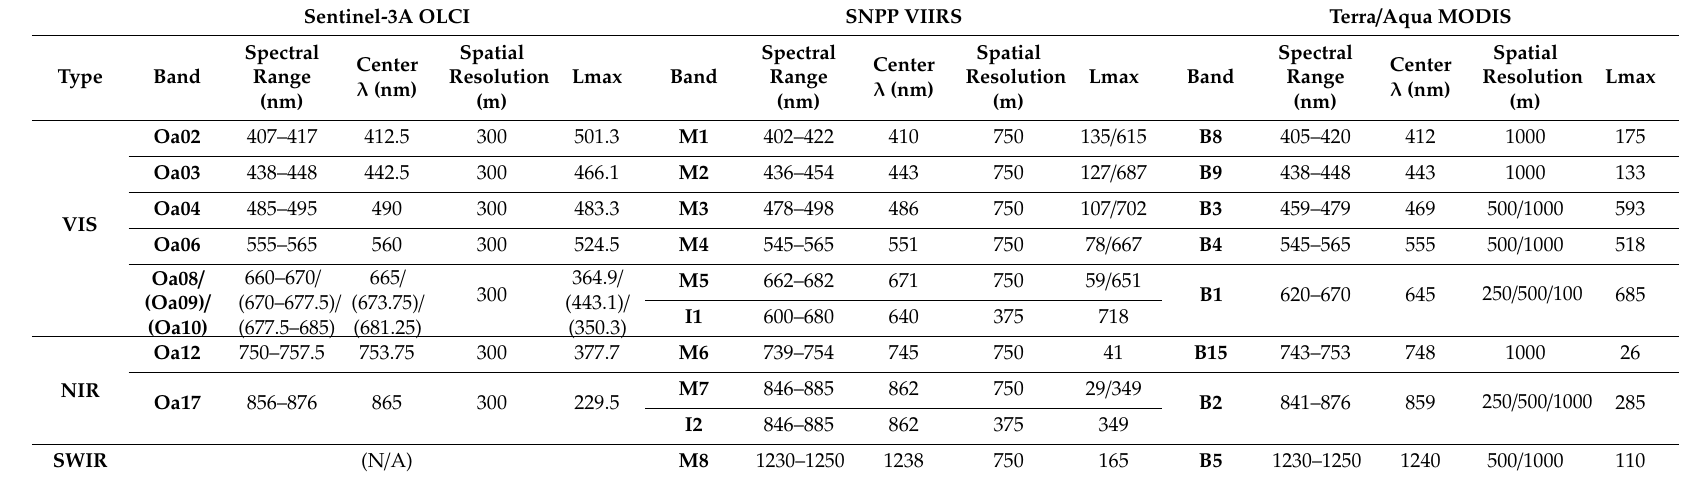
Table 2. The specifications of the matching RSBs of Sentinel-3A OLCI, SNPP VIIRS, and